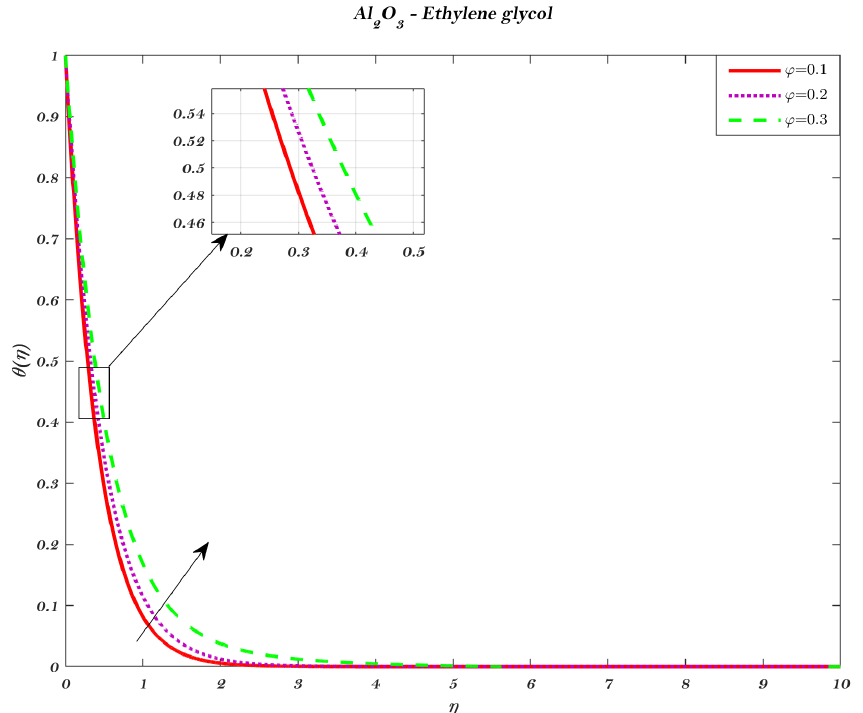
Figure 7. Temperature profile as a function of nanoparticle volume fraction ϕ with fix parameters (cid:101) = 0.02 ˘ a = 0.01, P r = 6.96 and R =